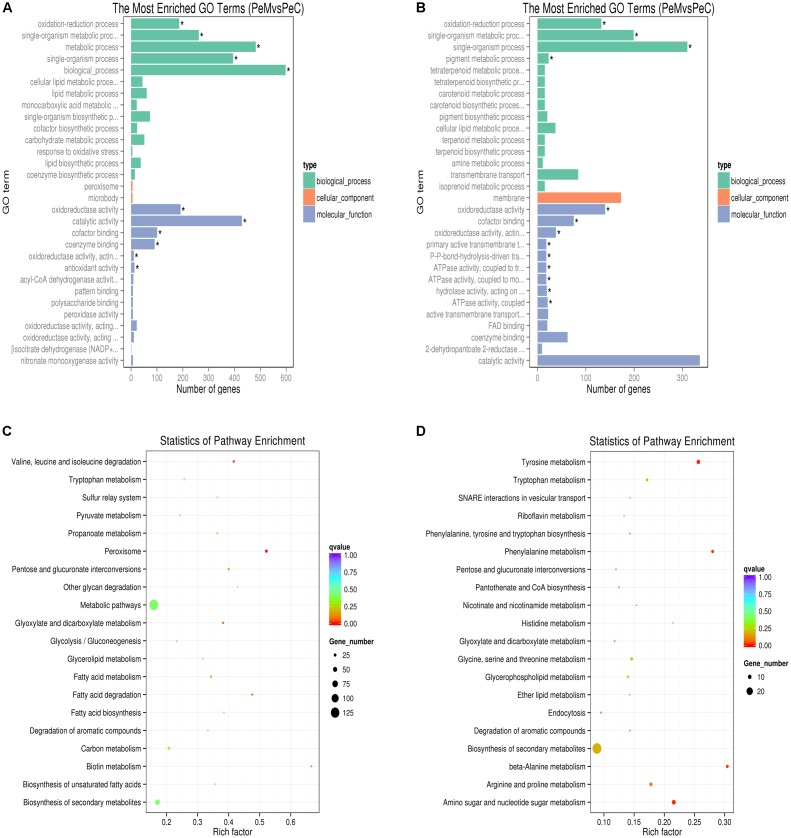
GO functional classification (A,B) and KEGG enrichment (C,D) of up-regulated (A,C) and down-regulated (B,D) DEGs. (A,B) The ordinate means GO term, the abscissa means the number of DEGs of each GO term. Different color means biological process, cellular component, and molecular function, respectively. “∗” means significant enrichment. (C,D) The ordinate means the name of the pathway, the abscissa means rich factor. The size of the plot means the number of DEGs in one KEGG, the color of the plot close to red means more significant enrichment.